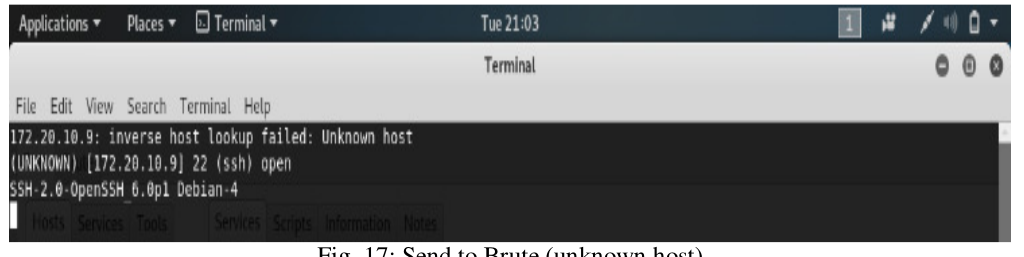
Fig. 17: Send to Brute (unknown host)